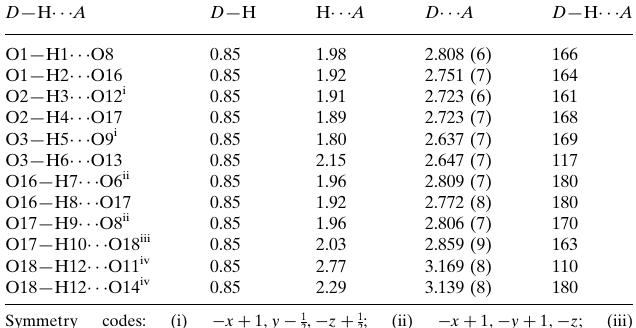
Hydrogen-bond geometry (A˚ , (cid:2)